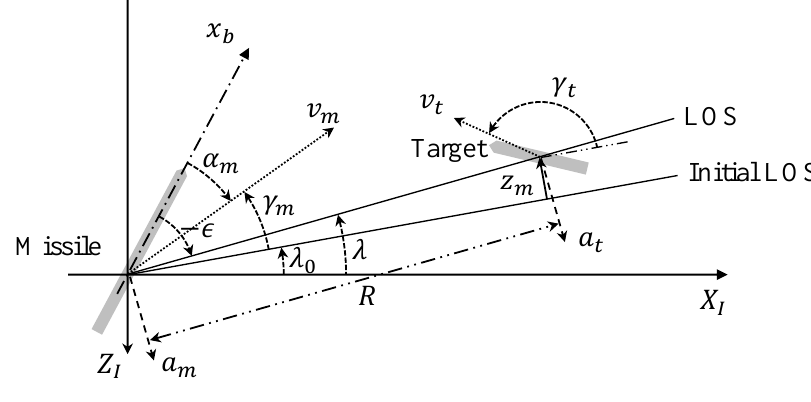
Figure 1. Two-dimensional engagement